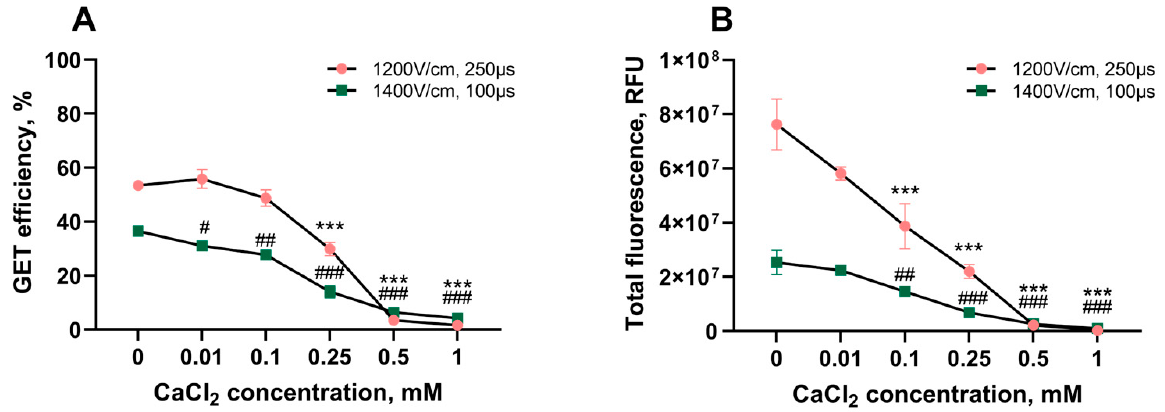
Figure 2. Dependence of pDNA electrotransfection efficiency ( A ) and total fluorescence intensity ( B ) on the strength of the applied electric field at different CaCl 2 concentrations. Cells were treated using one square pulse of 1200 V/cm for 250 μ s or 1400 V/cm for 100 μ s. Results were evaluated 24 h after electroporation. Error bars represent the standard error of the mean (SEM) of n = 9 experi- mental replicates. In case standard errors were lower than actual data points, error bars are not visible. The statistical significance between the control (0 mM) and the 0.01, 0.1, 0.25, 0.5, and 1 mM CaCl 2 concentrations is denoted by *** (1200 V/cm) and #, ##, and ### (1400V/cm). # represents p < 0.05, ## - p < 0.01, and *** or ### represents the p < 0.001